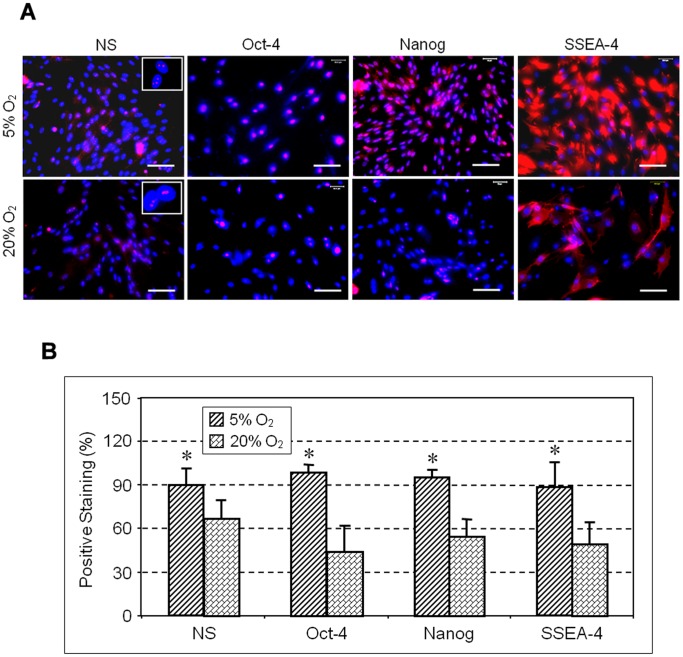
A. The expression of stem cell markers by hTSCs under hypoxic and normaxic culture conditions.hTSCs grown under hypoxic or normaxic conditions were analyzed by immunocytochemistry using specific antibodies to determine stem cell marker expression (See materials and methods for details). Compared to normaxic condition (20% O2), more hTSCs at hypoxic condition (5% O2) expressed nucleostemin (NS), Oct-4, Nanog, and SSEA-4, all of which are known stem cell markers. Insets indicate NC proteins in the nuclei of hTSCs. Nuclei were stained with Hoechst 33342. Scale bars: 100 µm. B. Semi-quantification of stem cell markers by staining. hTSCs specifically stained for NS, Oct-4, Nanog and SSEA-4 by immunocytochemical staining were counted to calculate percentage staining. As indicated, significantly higher percentages of hTSCs cultured under 5% O2 conditions expressed the stem cell markers (NS, Oct-4, Nanog, and SSEA-4) compared to those cultured under 20% O2 conditions (*P<0.05, with respect to hTSCs under 20% O2 culture conditions). Scale bars: 100 µm.